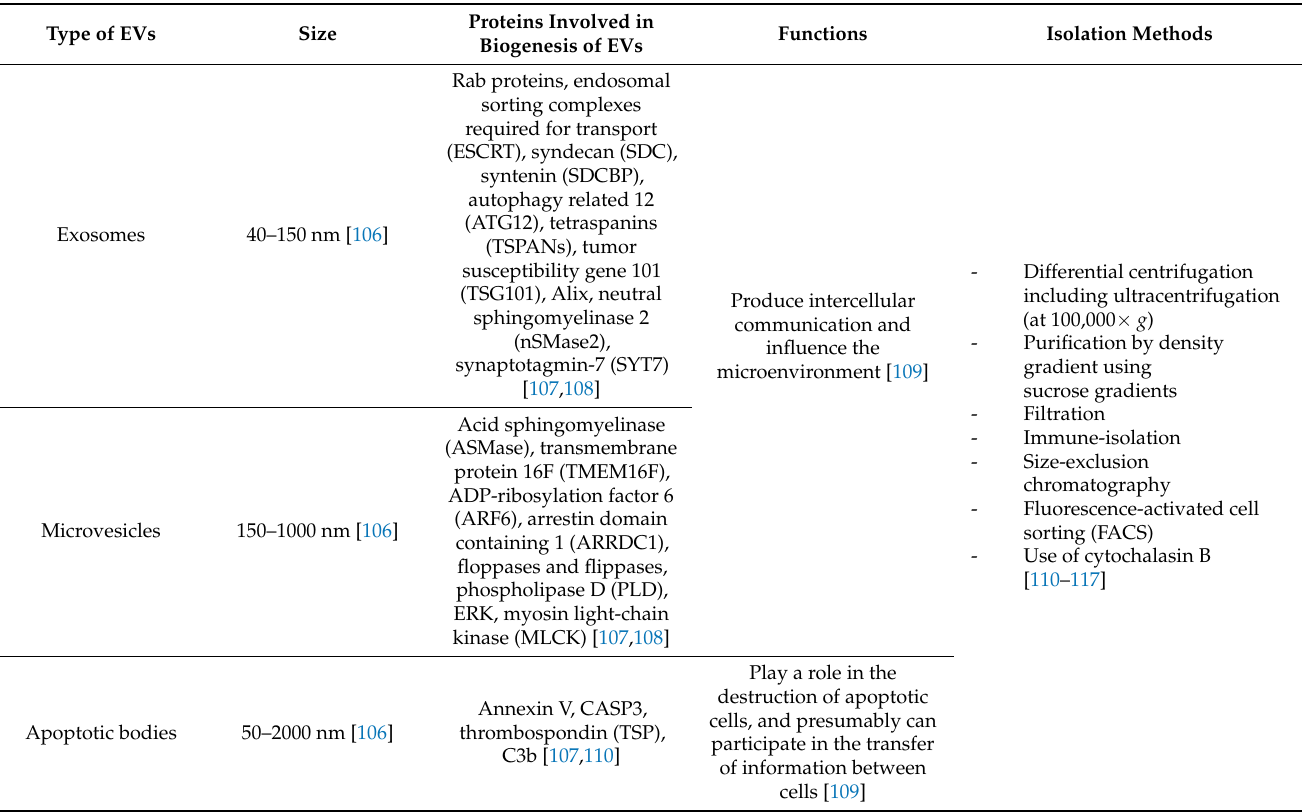
Table 1. Characterization of extracellular